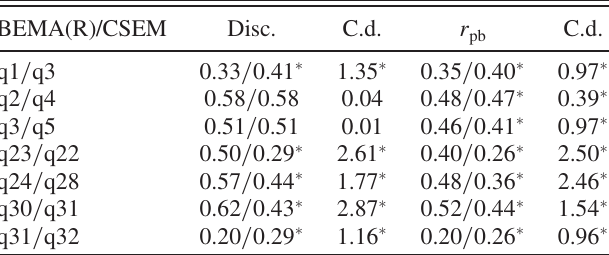
TABLE III. Comparison of classical discrimination and point- biserial values for questions on the BEMA(R) and CSEM that are the same. The numbers of the left of the “ / ” are for the BEMA(R) and to the right are for the CSEM. The entries marked with a (cid:4) were found to be statistically different. All other entries were found to be statistically different with p values < 0 . 001 . C.d stands for the absolute value of Cohen ’ s d